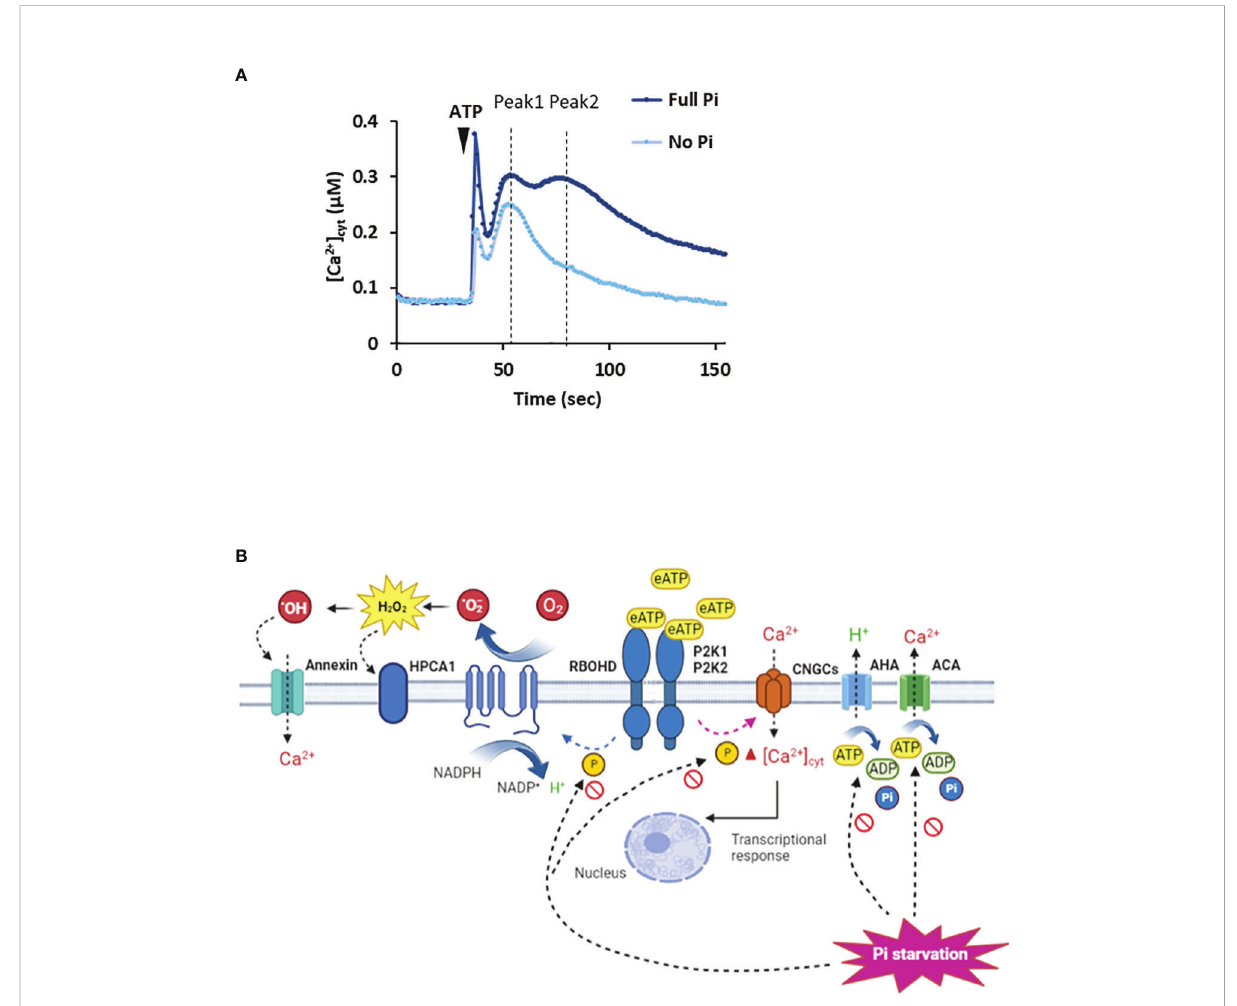
FIGURE 1 Extracellular ATP causes elevation of [Ca 2+ ] cyt . (A) Arabidopsis roots or root tips (expressing cytosolic aequorin as a [Ca 2+ ] cyt reporter) grown in full Pi medium respond to ATP addition with an initial [Ca 2+ ] cyt increase caused by mechanical perturbation, followed by an ATP-induced biphasic increase (Peak 1, Peak 2). In Pi-starved roots, the magnitude of the Peak responses is lessened. Schema based on results of Matthus et al., 2019a; Matthus et al., 2019b; Mohammad-Sidik et al., 2021; Matthus et al., 2022; Wang et al., 2022a. (B) In Pi-replete Arabidopsis , extracellular ATP (eATP) is recognized by the plasma membrane P2K1 and P2K2 receptors. This can lead to opening of CNGC channels by an unknown mechanism to elevate [Ca 2+ ] cyt (Sun et al., 2021; Wu et al., 2021; Duong et al., 2022; Wang et al., 2022a). In guard cells, P2K1 can activate RBOHD by phosphorylation (Chen et al., 2017) whilst in roots its target may be RBOHC (Demidchik et al., 2009). The resultant extracellular ROS could be sensed by the HPCA1 hydrogen peroxide receptor (Wu et al., 2020) although there is no evidence for this yet. Peroxide could enter the cytosol through aquaporins (not shown) or be converted to hydroxyl radicals to activate Annexin1. H + -ATPases (AHA) promote hyperpolarised membrane voltage (Haruta and Sussman, 2012) to facilitate Ca 2+ channel opening whilst Ca 2+ -ATPase activity would help terminate the [Ca 2+ ] cyt signal (Costa et al., 2017). Under Pi deprivation, cytosolic ATP limitation may impair AHA/Ca 2+ -ATPase activity and potentially the phosphorylation activity of the receptors. The involvement of P2K2 may be questioned (Matthus et al., 2022). The identities of the Ca 2+ channels may change and the involvement of RBOHs has yet to be